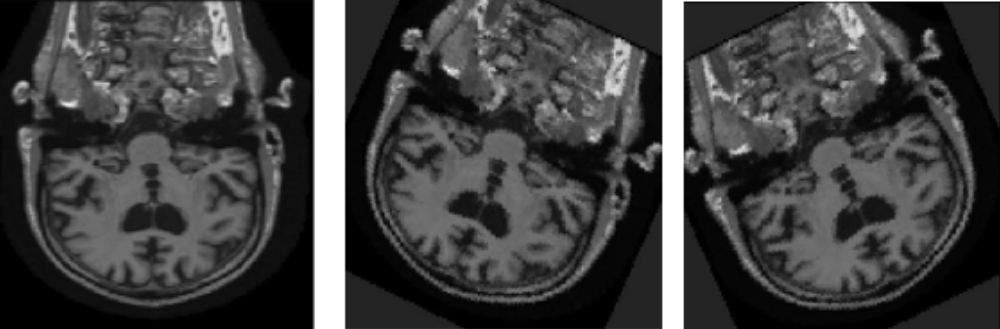
Figure 7. The image rotated 25 and − 25 degrees.